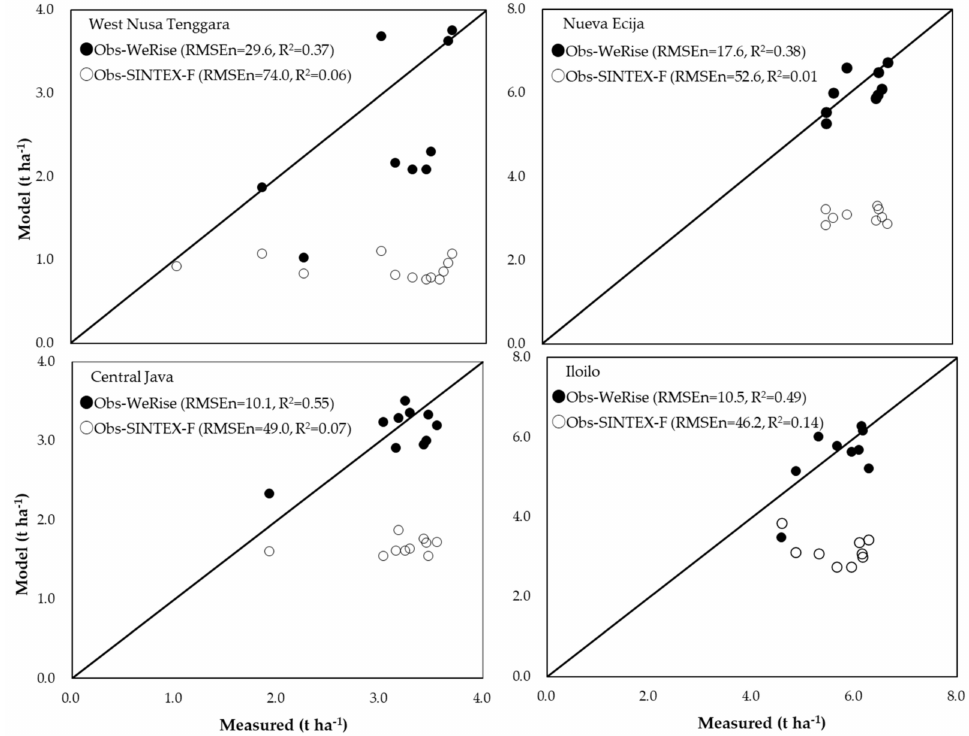
Figure 6. Simulated versus measured grain yields derived from a data set using Inpari 41 for Indonesia and NSIC Rc216 for the